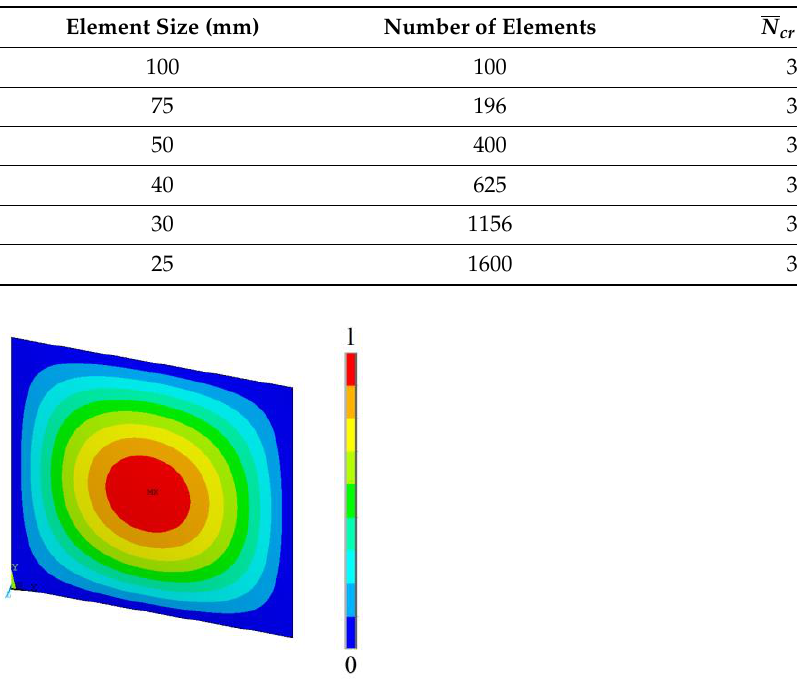
Figure 3. Out-of-plane displacement due to the biaxial elastic buckling.